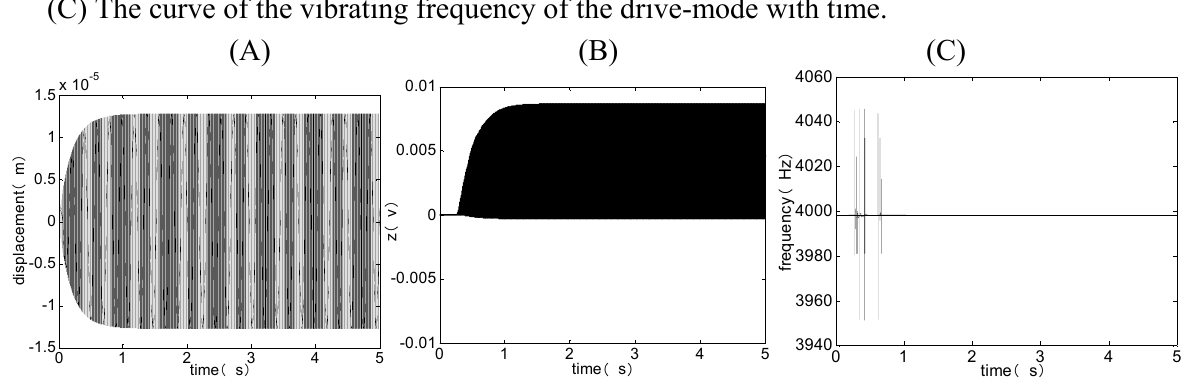
Figure 6. The simulation curves of closed-loop driving when 0.7 of the drive displacement with time. (B) The curve of the output of integrator z(t) with time. (C) The curve of the vibrating frequency of the drive-mode with